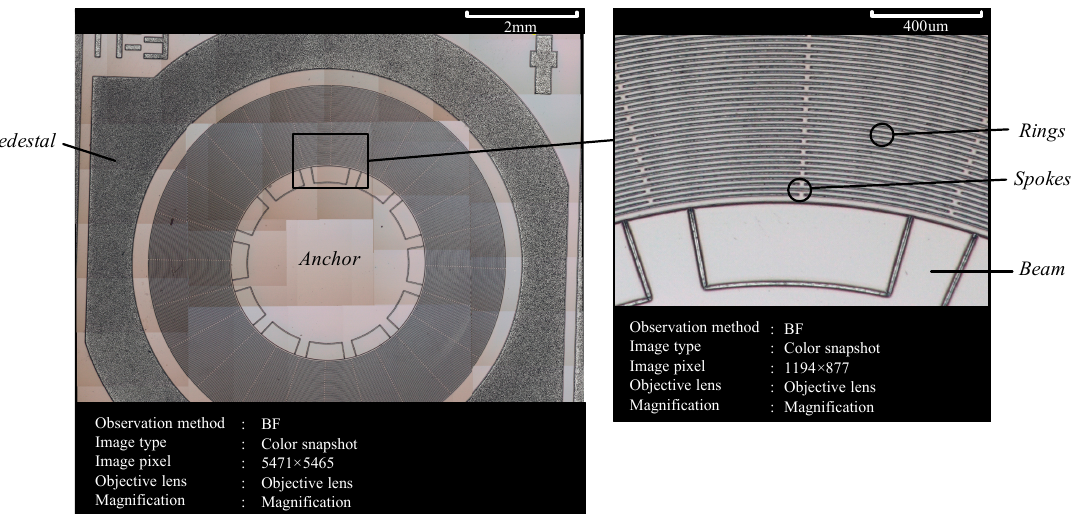
Figure 15. The photo of the fabricated micro optoelectromechanical system resonator gyroscope Figure 15. SEM image of epi-sealed MOEMS-RG. (MOEMS-RG).